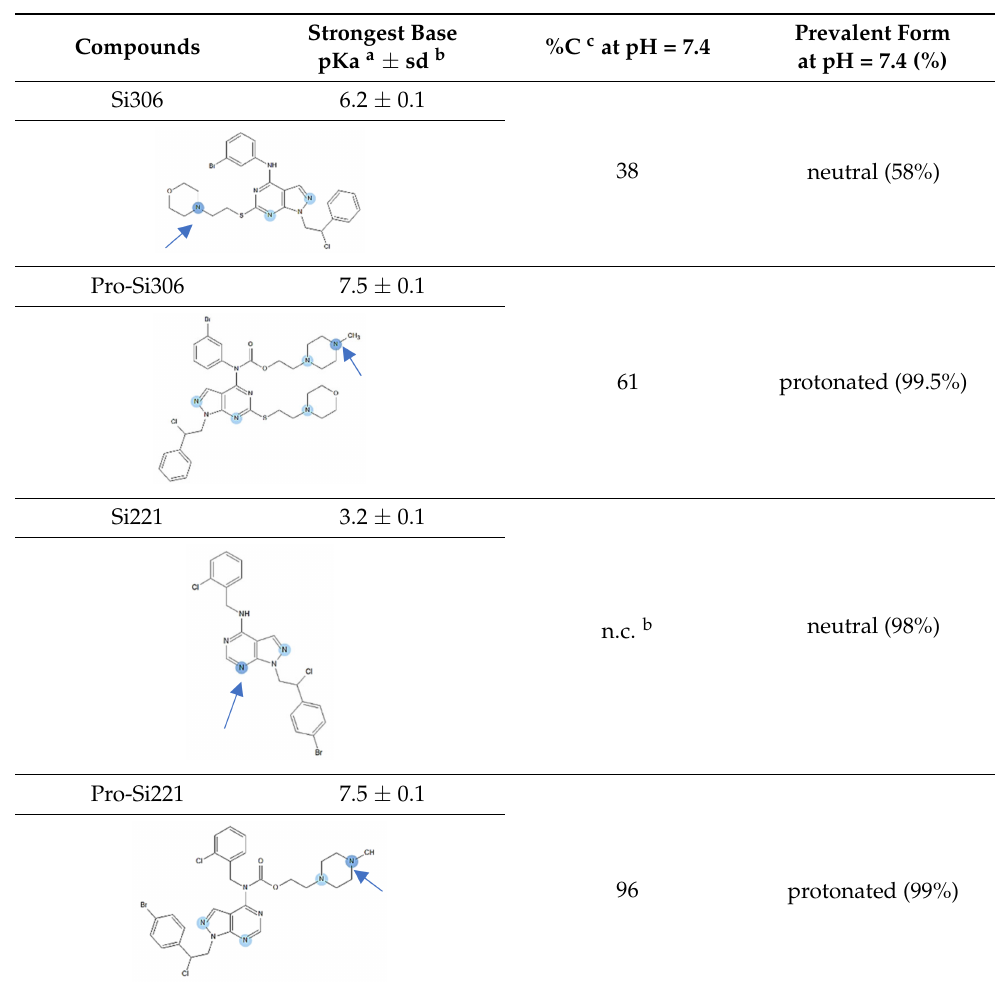
Table 3. Prevalent forms of the studied compounds at physiological pH = 7.4.